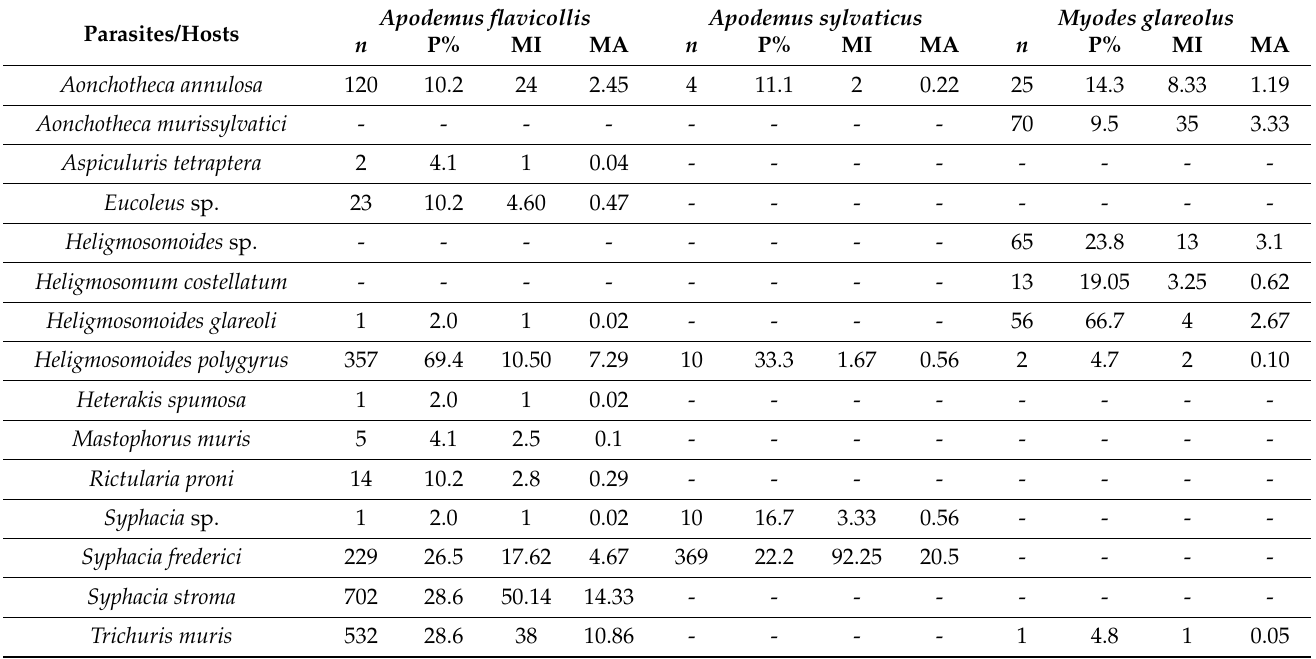
Table 2. Parasitological parameters for all nematode species in three small rodent species from localities in